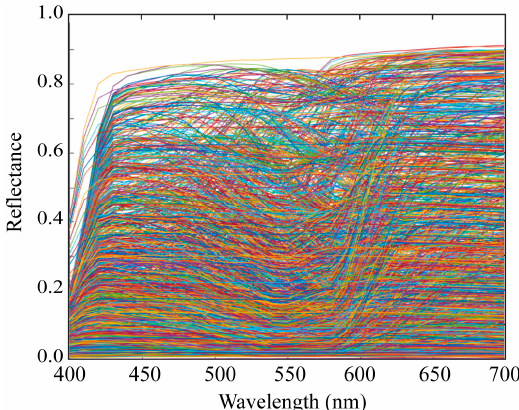
Figure 9. Complete set of the surface–spectral reflectances measured from all the Munsell color chips.